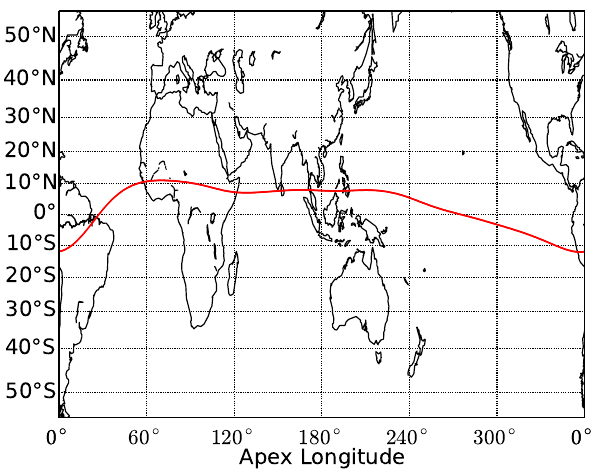
Fig. 1. Map of the Earth as a function of apex longitude and ge- ographic latitude overlaid with the geomagnetic equator in red as determined by the International Geomagnetic Reference Field . 0 ◦ apex longitude is approximately − 72 ◦ geographic longitude.